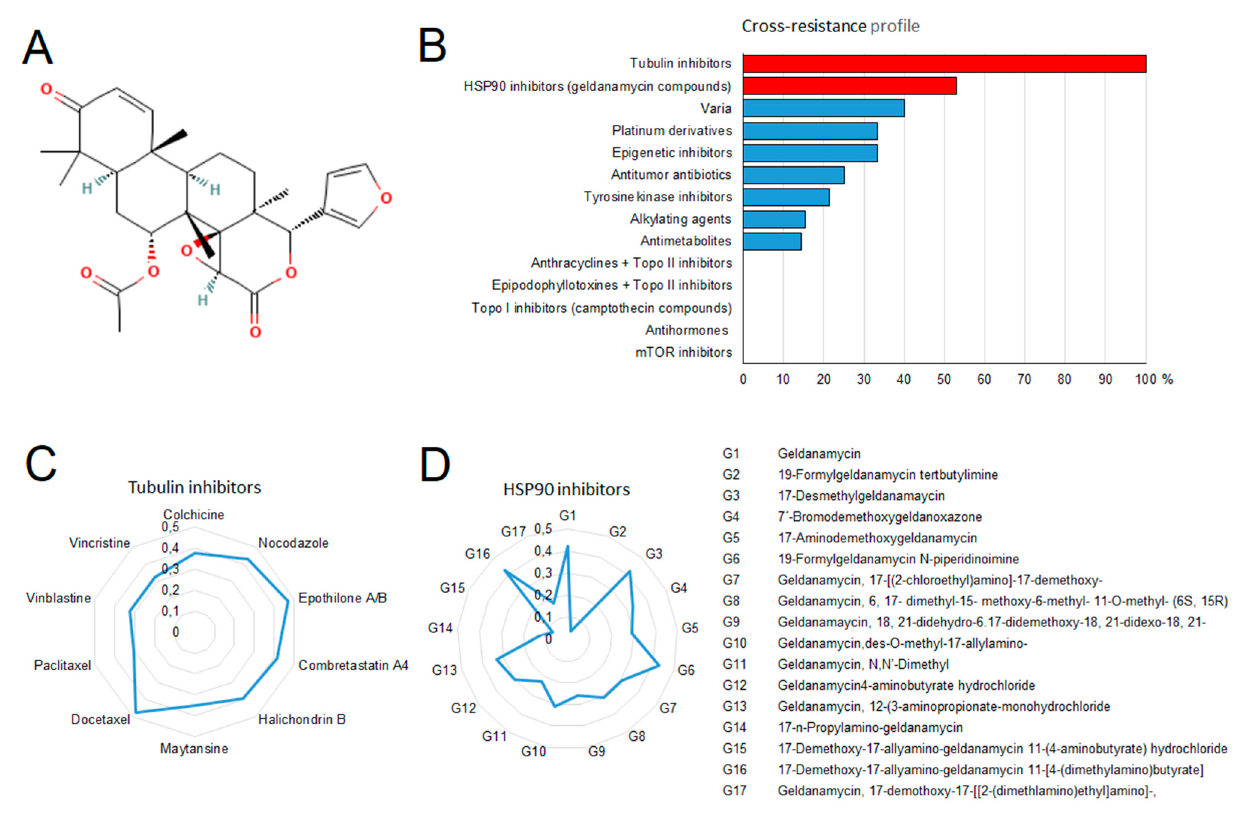
Figure 5. Cross-resistance profiling of gedunin to standard anticancer drugs. ( A ) Chemical structure of gedunin. ( B ) Percentage of standard anticancer drugs from different pharmacological classes that significantly correlated to the responsiveness of NCI tumor cell lines to gedunin (with p < 0.05 and r > 0.3 as cutoff values). Oncobiograms of ( C ) tubulin-inhibiting drugs or ( D ) geldanamycin deriva- tives correlating to the response of NCI tumor cell lines to gedunin.